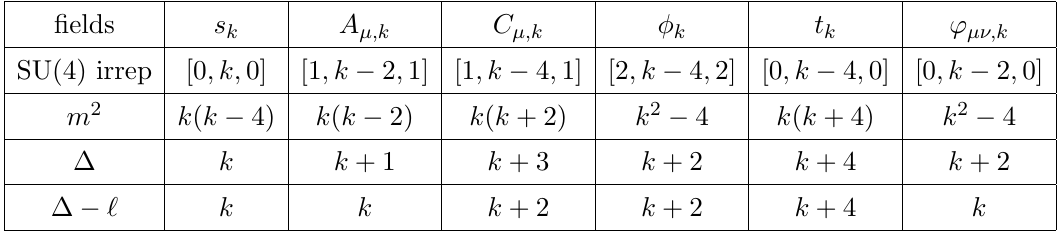
Table 1 . KK modes contributing to exchange diagrams with four external superprimary modes s k